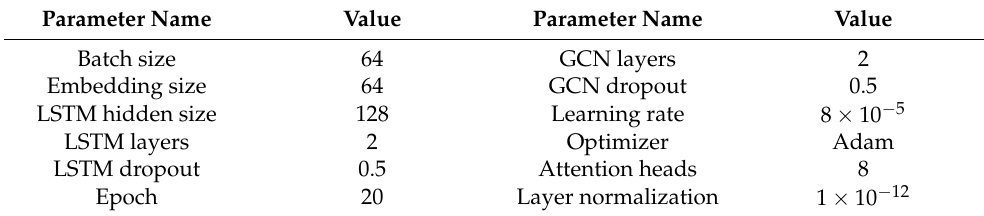
Table 1. Model parameter